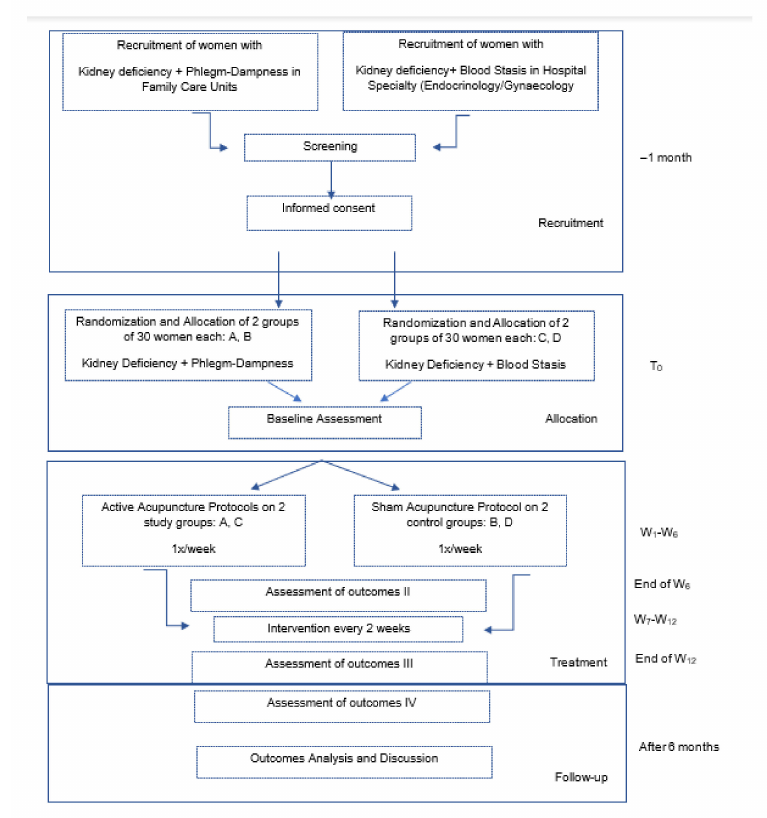
Figure 2. Flowchart of the study